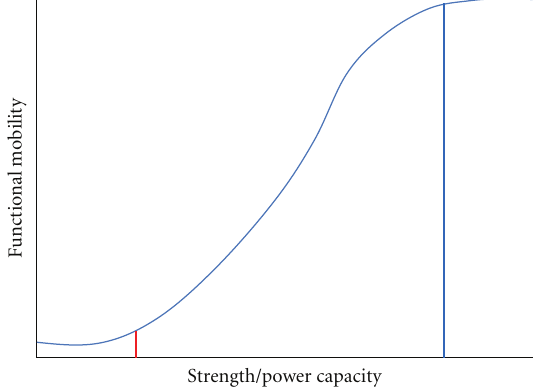
Figure 2: Theoretical association between muscle strength and functional